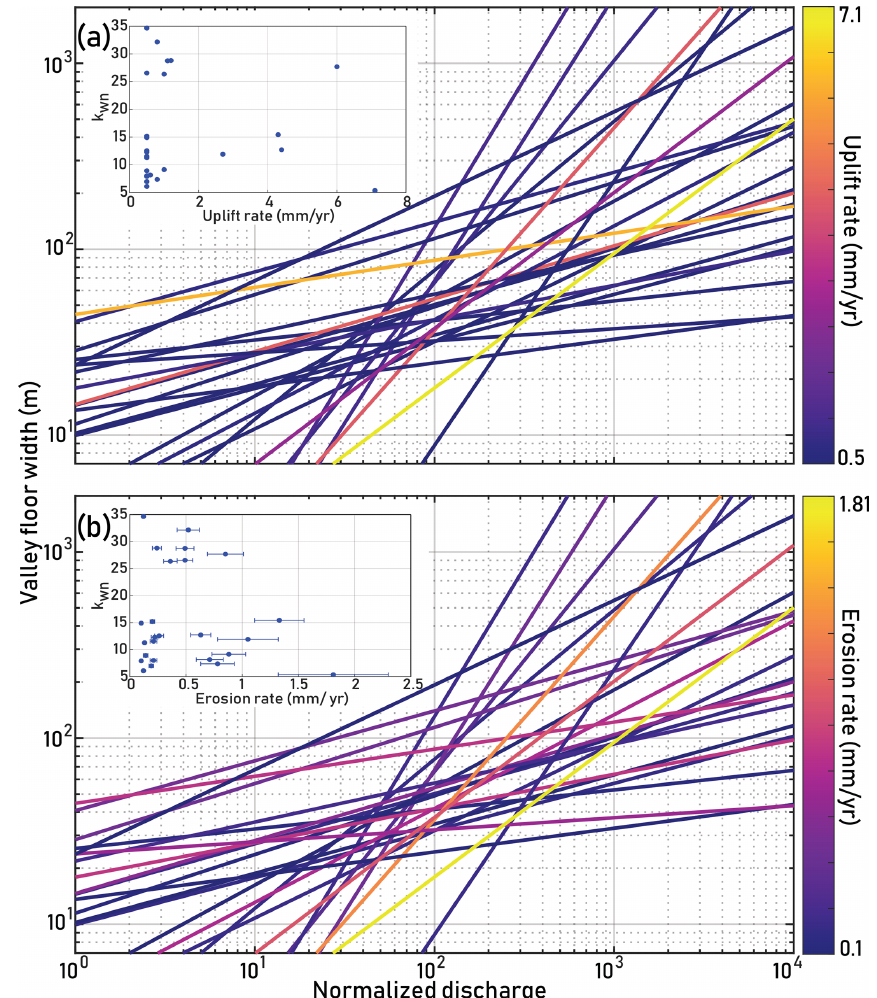
Figure 8. Best-fit lines for valley floor width vs. discharge for basins shown in Fig. 6. (a) Lines show best-fit solutions for k w and b in Eq. (6) and are colored by estimated uplift rate for the basin (Lavé and Avouac, 2001). Spearman’s ρ = 0 . 2614 with P = 0 . 2069 for b vs. uplift rate. Inset: k wn versus uplift rate. Spearman’s ρ = 0 . 3257 with P = 0 . 3257. (b) Lines show best-fit solutions for k w and b in Eq. (6) and are colored by Beryllium-10-derived denudation rate for the basin (Godard et al., 2014). Spearman’s ρ = 0 . 1289 with P = 0 . 5390 for b vs. denudation rate. Inset: k wn versus denudation rate. Spearman’s ρ = 0 . 0758 with P = 0 .